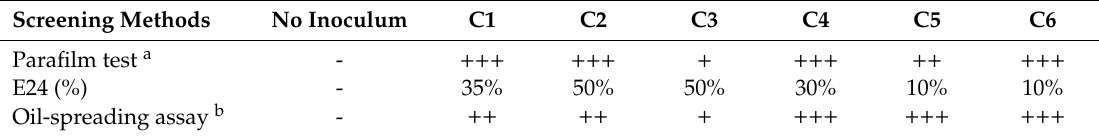
Figure 5. Percentage of TPH degradation and surface tension reduction by the 15th generation of six consortia (After 15 days of incubation at 30 °C and 140 rpm). Table 1. Qualitative analysis of biosurfactants among the